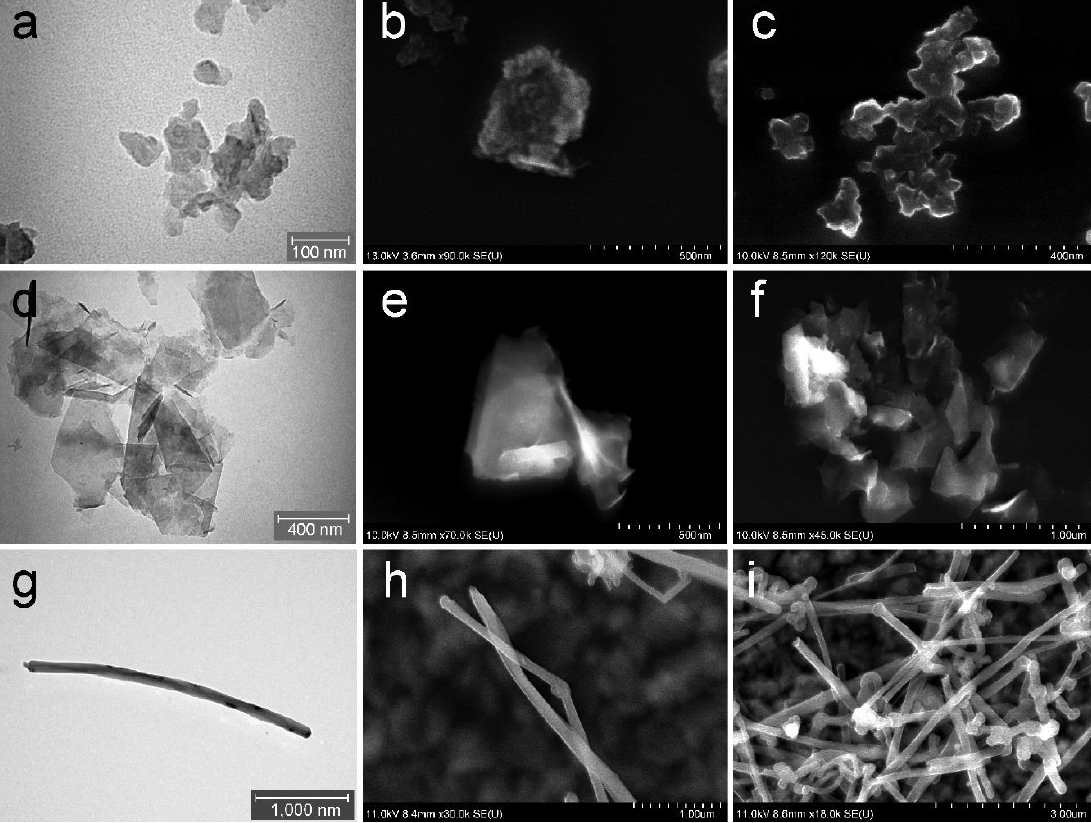
Figure 1 . Characterisation of C-BNM by electron microscopy: ( a ) TEM and ( b , c ) SEM detail of the GP1 forming small aggregates; ( d ) TEM detail of the GP2; ( e ) SEM detail of a structure of GP2 single platelet and ( f ) forming clusters; ( g ) TEM detail of single MWCNT; ( h ) SEM detail of a structure of MWCNT with ( i ) forming clusters.